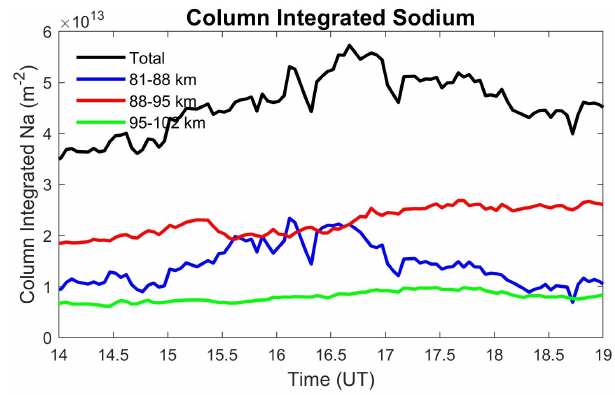
Figure 12. Column-integrated sodium densities in selected altitude regions (blue, red and green lines) to compare with the total column abundance (black